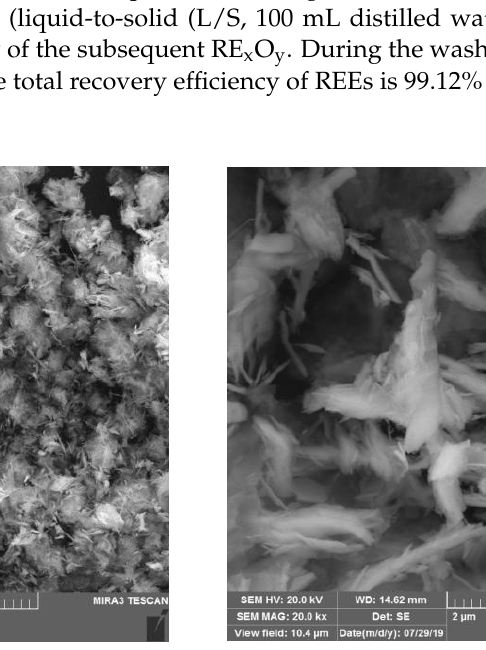
Figure 12. SEM images of precipitation products.